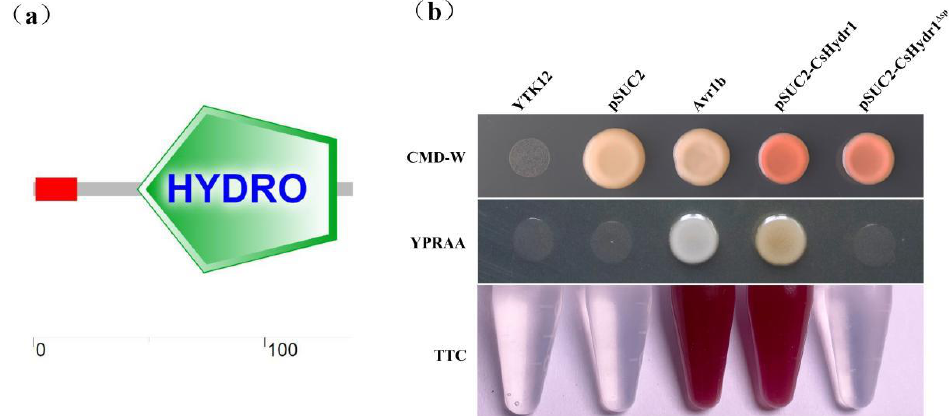
Figure 1. Protein structure and secretion of CsHydr1 in C. siamense . ( a ) SMART analysis of CsHydr1 protein structure. The red region is the signal peptide. The green region is the HYDRO domain; ( b ) Functional validation of the signal peptide of CsHydr1 using the yeast invertase secretion assay. The full-length and C -terminal amino acid residue sequences without signal peptide ( CsHydr1 Δ sp ) of the Cs Hydr1 gene were fused into the pSUC2 vector and transformed into the yeast YTK12 strain. The signal peptide of a known secreted protein Avr1b was used as a positive control. The untransformed YTK12 and YTK12 carrying the pSUC2 vector were used as a negative control. Yeast growth on the CMD-W medium confirmed that the vector had transformed into the yeast cell. The growth in the YPRAA medium and color change of TTC confirmed invertase secretion.